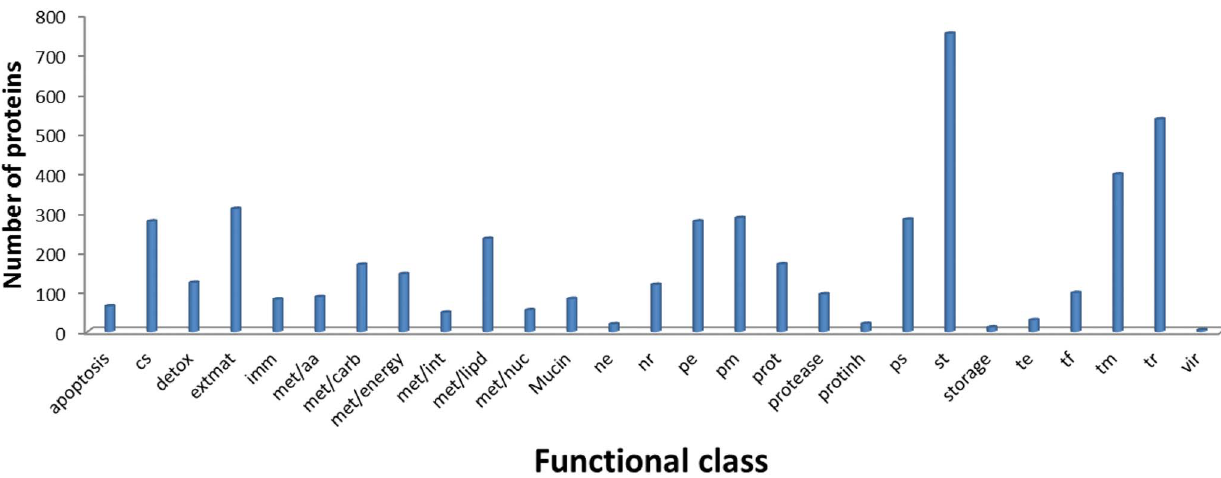
Figure 3. Classification of the annotated An.aquasalis proteins in functional categories. The numbers in parenthesis indicate the number of proteins in each category. apoptosis (64), cs- Cytoskeletal (278), detox- Detoxification (123), extmat- Extracellular matrix and adhesion (310), imm- Immunity (81), met/aa- Amino acids metabolism (87), met/carb- Carbohydrate metabolism (169), met/energy- Energy metabolism (145), met/int- Intermediary metabolism (48), met/lipd- Lipid metabolism (234), met/nuc- Nucleotide metabolism (54), mucin (82), ne- Nuclear export (19), nr- Nuclear regulation (118), pe- Protein export machinery (278), pm- Protein modification machinery (287), prot- Proteasome machinery (170), protease (94), protinh- Protease inhibitor (20), ps- Protein synthesis (283), st- Signal transduction (752), storage (11), te- Transposable element (29), tf- Transcription factor (97), tm- Transcription machinery (397), tr- Transporters and storage (536), vir- Viral product (4).